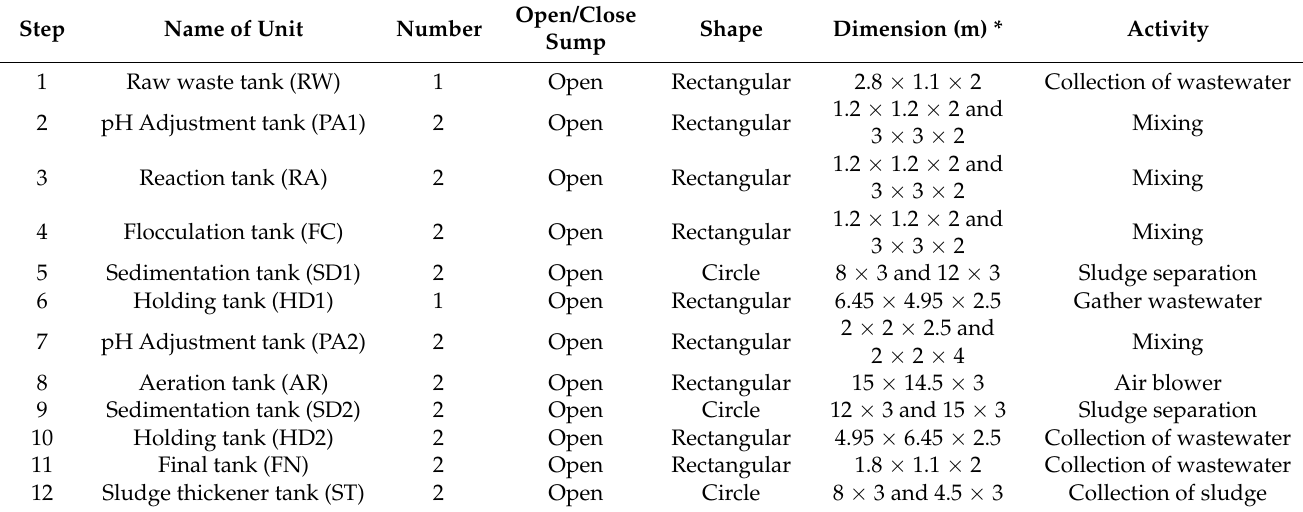
Table 2. Characteristics of processing units of WWTs.